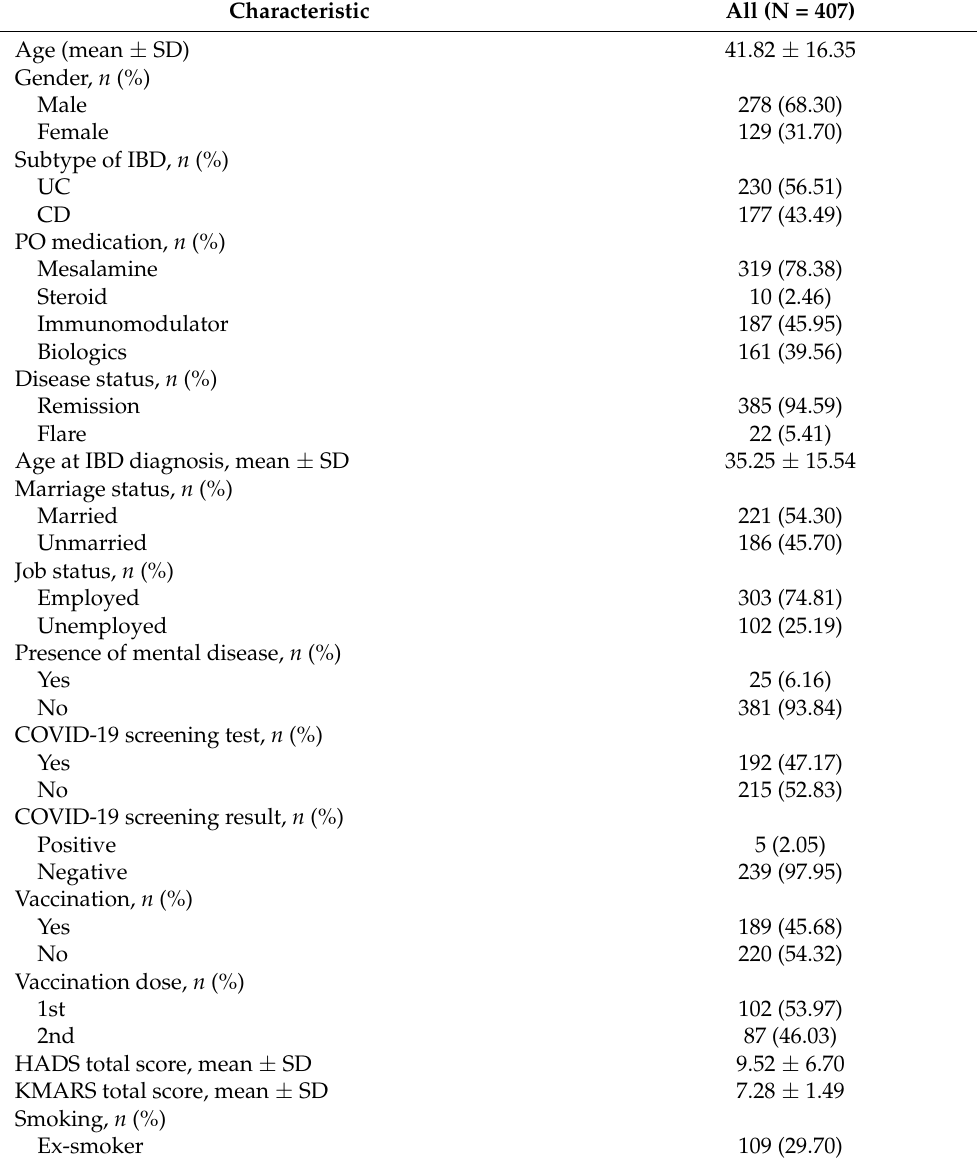
Table 1. Characteristics of patients with IBD responding to the questionnaire. Characteristic All (N = 407) 41.82 ±